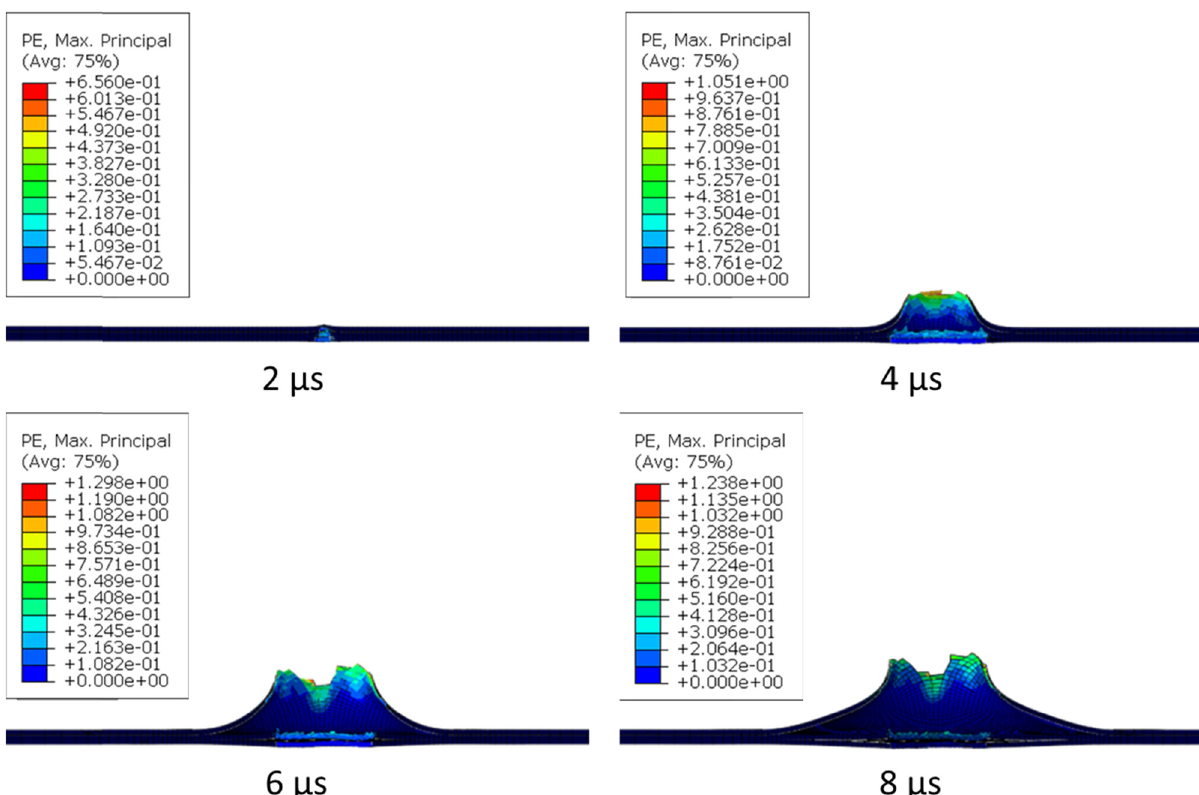
Figure 16: Plastic strain distribution and deformation for model 12 against conical